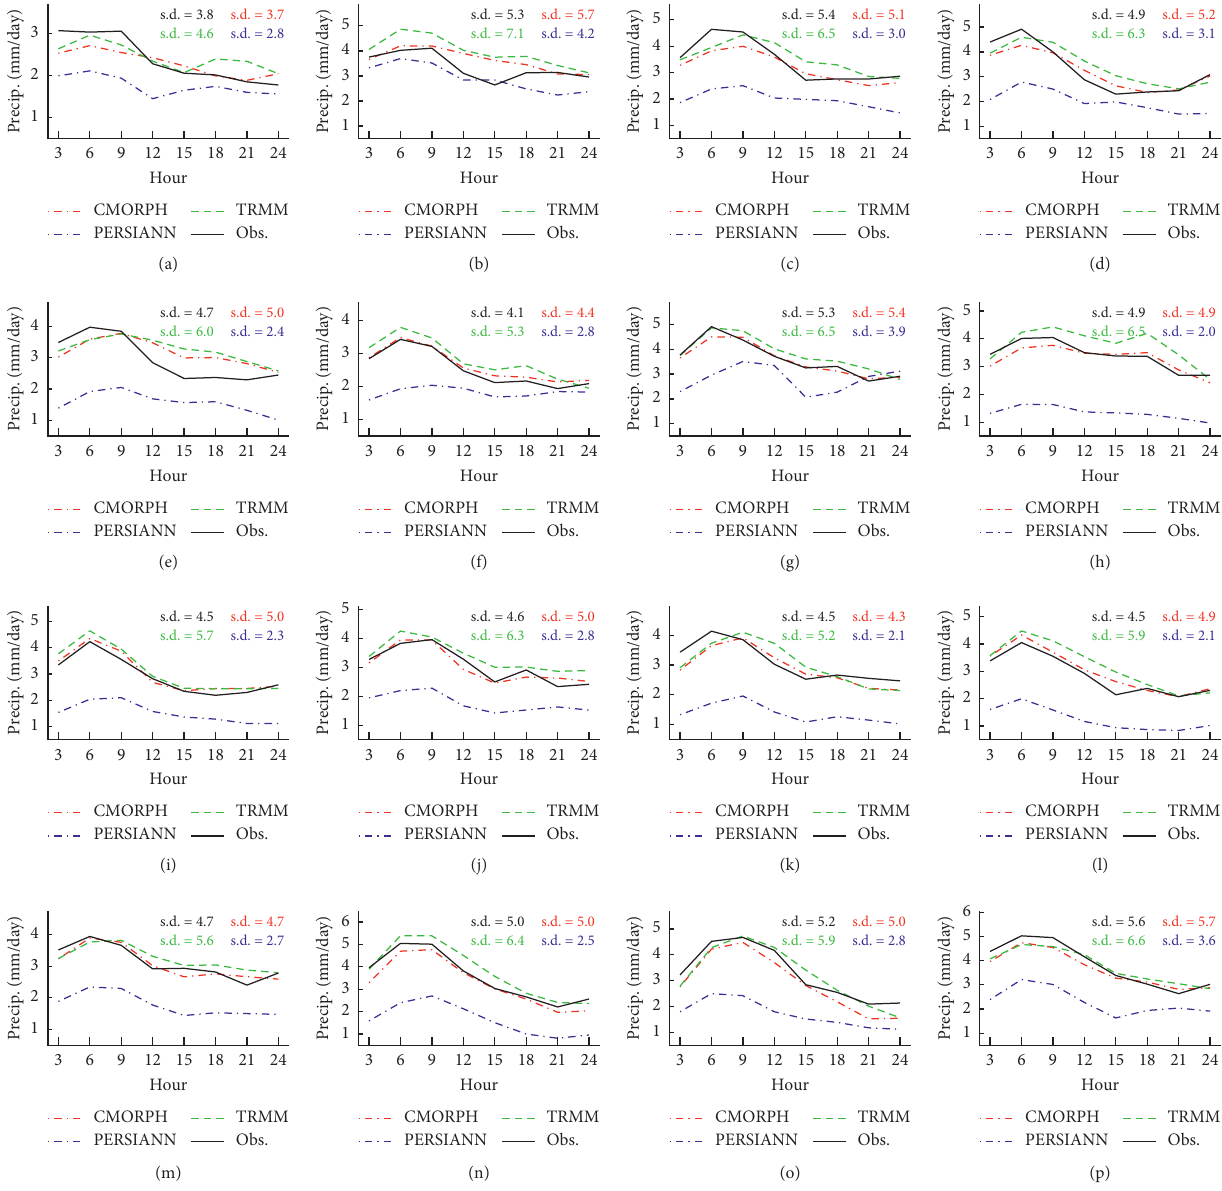
Figure 3: The annual mean 3-hourly precipitation rate over the Three Gorges Reservoir area from the observation and the satellite estimates during the period 2001–2016 (units: mm/hour). The mean standard deviations (s.d.) of diurnal anomalies were annotated on each